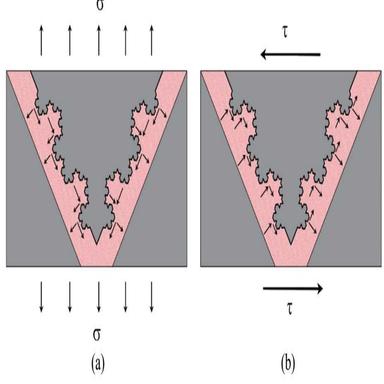
Rigid tooth models of a Koch fiber – matrix interface loaded in tension (a) and compression (b).